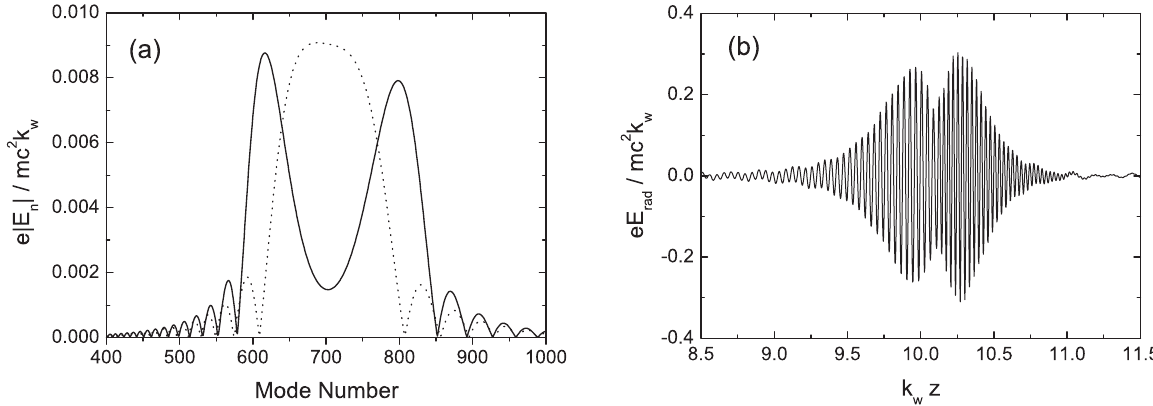
. (a) Mode amplitude spectrum. w ) at the same moment. (b) The pulse shape of radiation field w